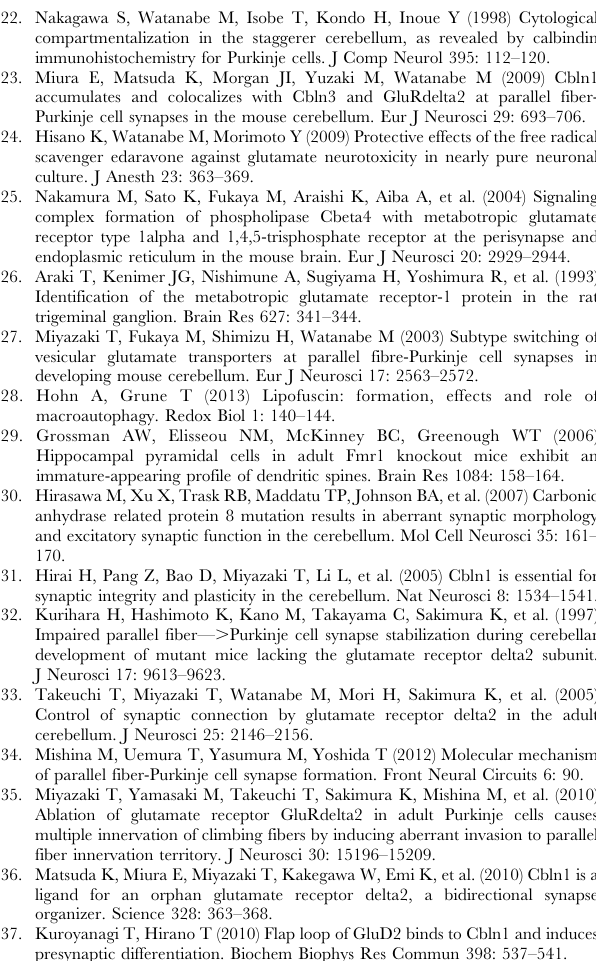
Figure S6 Detection of a large deletion of the grid2 DNA and GluD2 protein in ts3 mutant mice. Sequencing analysis revealed a 1001 bp deletion in the ts3 grid2 cDNA corresponding to sequences from exon 3 to 8 (highlighted in A ), causing deletion of 333 amino acids (83-415) in the GluD2 protein (highlighted in B ). This DNA deletion also results in a frame-shift mutation, and the final gene product is 124 amino acids in length (see Fig.